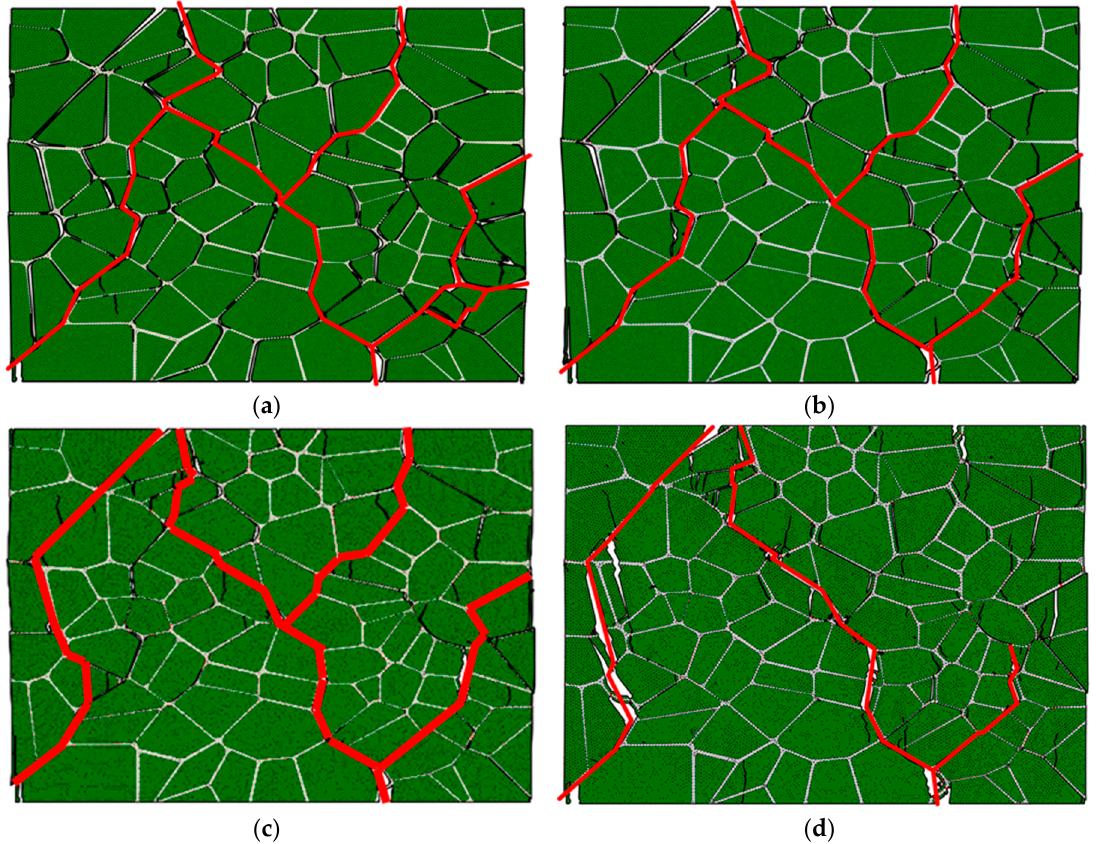
Figure 23. The failure path for di ff erent interface strengths, ( a ) 2 MPa, ( b ) 4.2 MPa, ( c ) 5 MPa, and ( d ) 7 MPa under compression